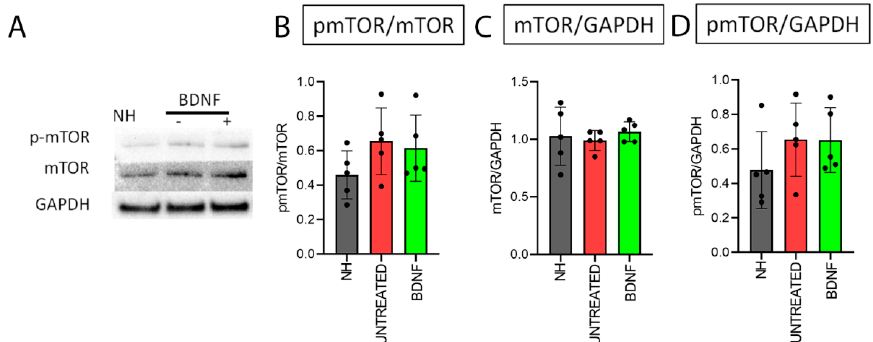
Figure 11. Protein quantification of pmTOR and mTOR. ( A ) Representative Western blot bands (original Western blot bands are shown in Supplementary Figure S2). Western blot analysis of pmTOR/mTOR ( B ), mTOR/GAPDH ( C ) and pmTOR/GAPDH ( D ) on organ of Corti samples from all the experimental groups. Histograms show mean ± SD; the dots indicate the densitometric values for individual samples ( n = 5; each sample is a pool of two organs of